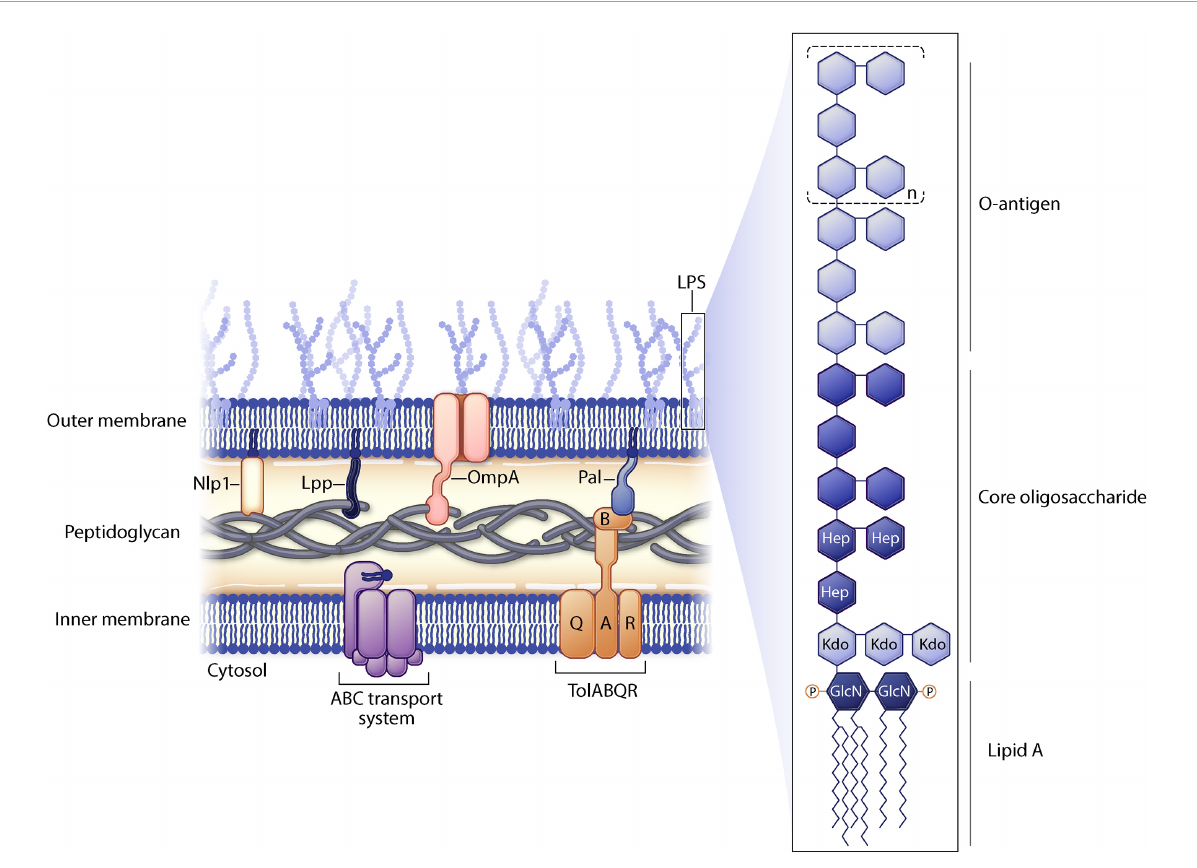
FIGURE2 Gram negative cell membrane structure. Selected proteins manipulated in outer membrane vesicle (OMV) engineering are shown. Lipopolysaccharide (LPS) substructures are